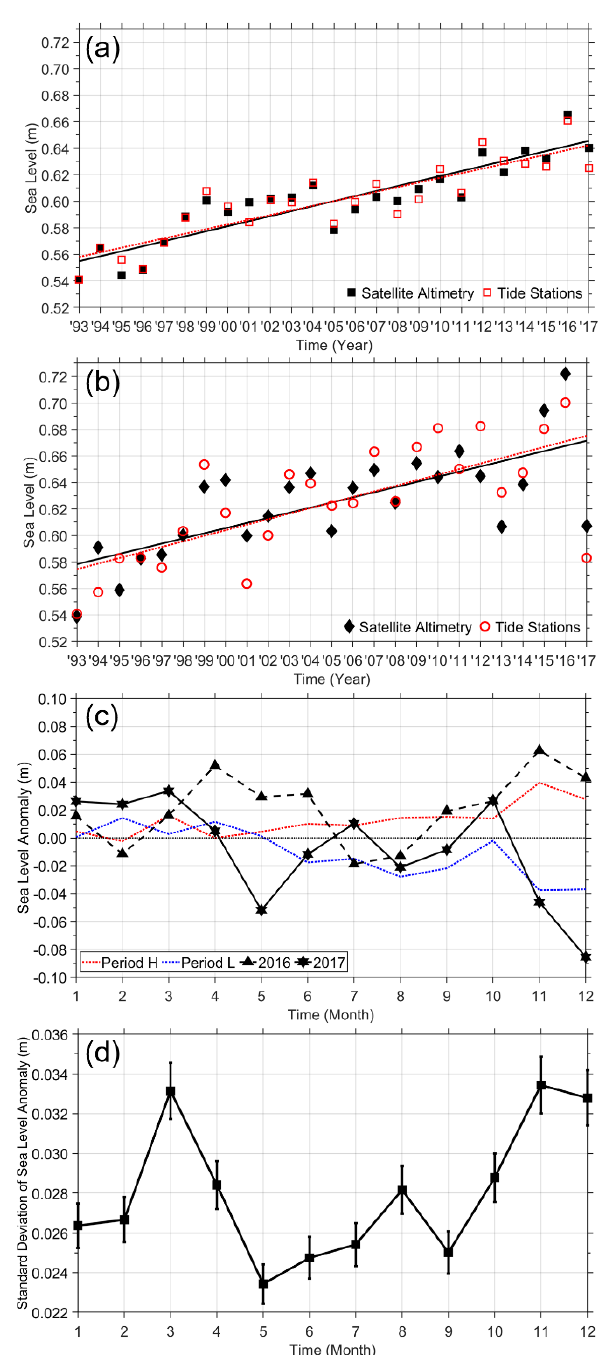
Figure 2. Time series of ( a ) annual mean and ( b ) winter (ND) mean NEAMS sea levels estimated from satellite altimetry (black squares and diamonds) and tide-gauge observations (red open squares and circles) from 1993 to 2017, ( c ) detrended monthly mean NEAMS sea levels in Period H (red dotted line), Period L (blue dotted line), 2016 (dashed line with black triangles), and 2017 (solid line with black hexagrams), and ( d ) monthly series of an interannual spread of the climatological mean NEAMS sea levels derived from mean (squares) and standard deviation (vertical bars) of 25 different subsamples of monthly series for a period of 24 years among the total period of 25 years from 1993 to 2017.